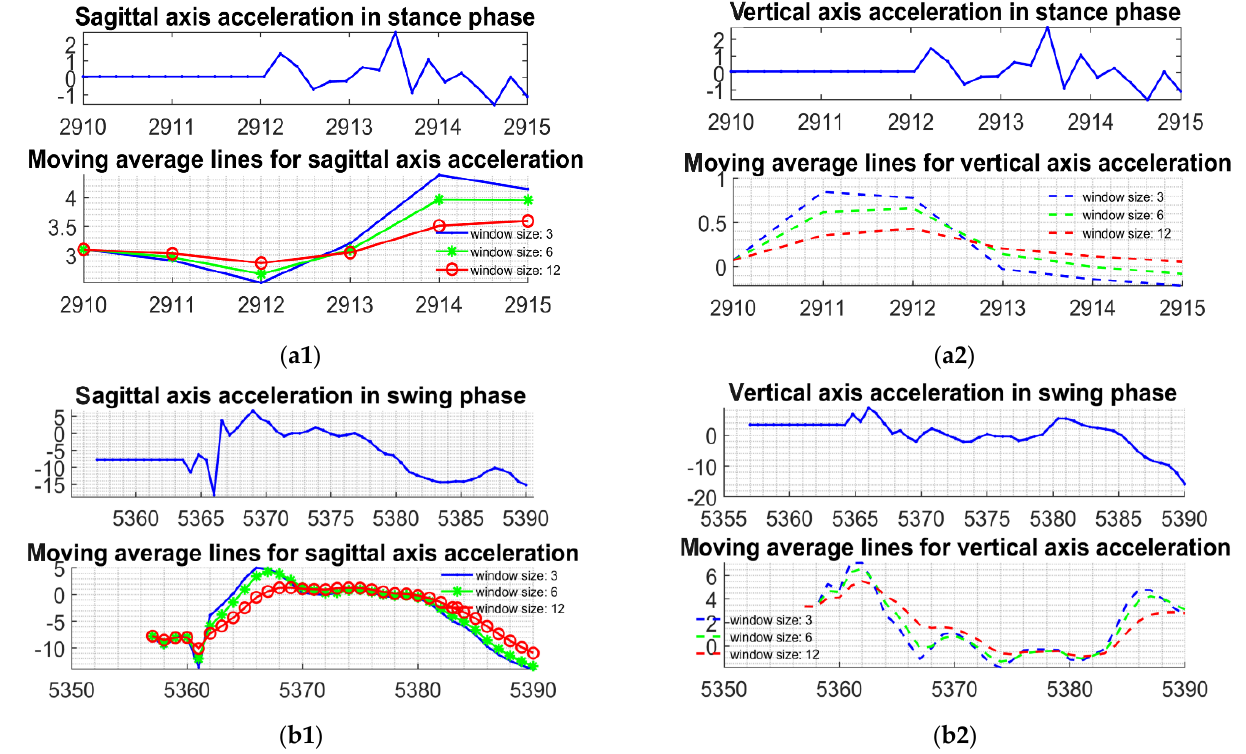
Figure 11. In fast and slow walking, the acceleration within the stance phase and the swing phase have comparable magnitude and similar fluctuation trends, which is the source of the stance phase identification error. The methods relying on thresholds will fail in such cases. ( a1 ) Sagittal acceleration and its moving average lines in stance phase during fast walking; ( a2 ) Vertical acceleration and its moving average lines in stance phase during fast walking; ( b1 ) Sagittal acceleration and its moving average lines in swing phase during slow walking; ( b2 ) Vertical acceleration and its moving average lines in swing phase during slow walking.